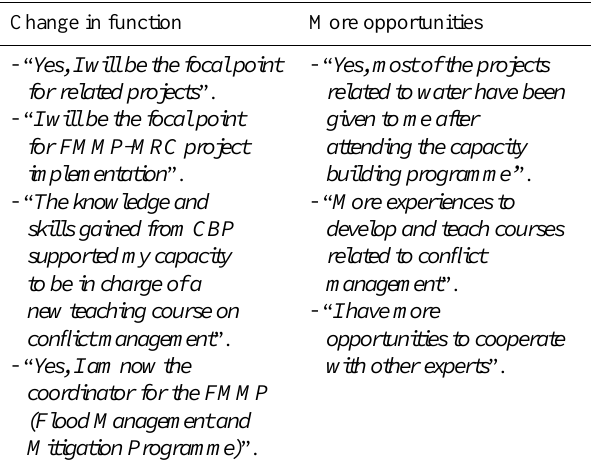
Table 9. Quotes given on change of function and/or having